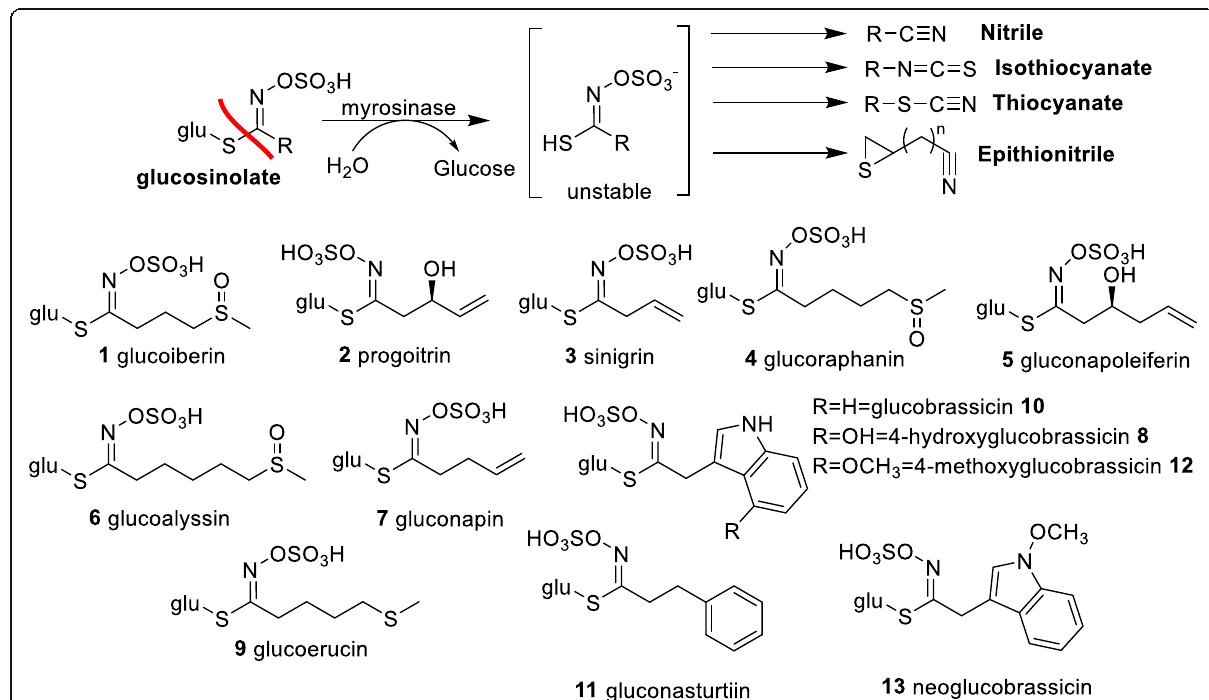
Fig. 2 Detected glucosinolates in the Brassica microgreens and the general myrosinase-catalyzed breakdown of glucosinolates into bioactive cyanates and nitriles. GLS, glucosinolates; glu, glucose. Compounds are 1, glucoiberin; 2, progoitrin; 3, sinigrin; 4, glucoraphanin; 5, gluconapoleiferin; 6, glucoalyssin; 7, gluconapin; 8, 4-hydroxyglucobrassicin; 9, glucoerucin; 10, glucobrassicin; 11, gluconasturtiin; 12, 4- methoxyglucobrassicin; 13,